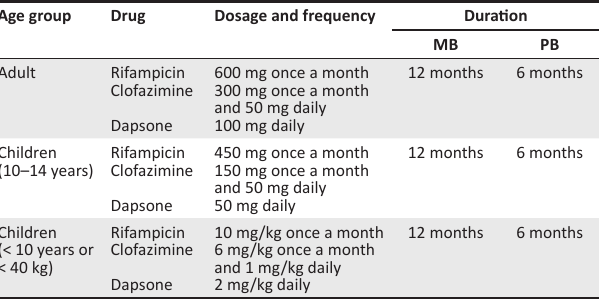
TABLE 2: Common signs of leprosy.